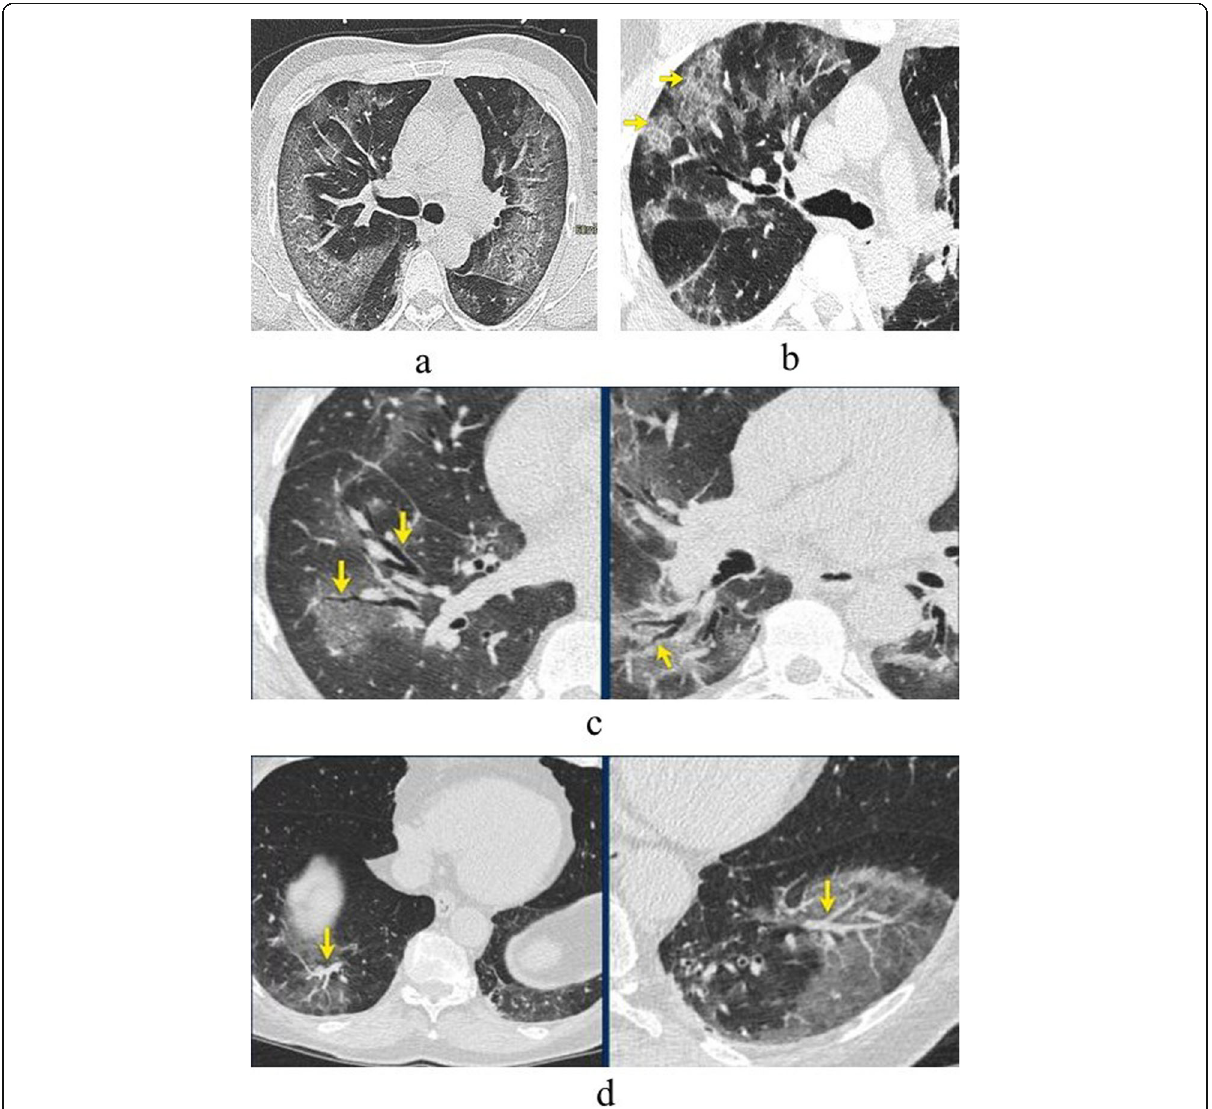
Fig. 3 Common image findings observed in lung CT scans of the patients infected with COVID-19. a Ground-glass opacity; b Crazy paving; c Traction bronchiectasis; d Vascular dilation